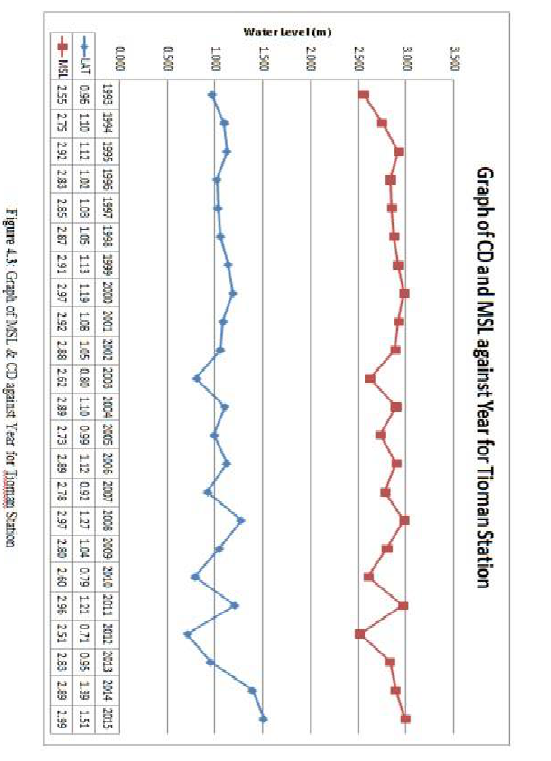
Figure 11. Lumut Tide